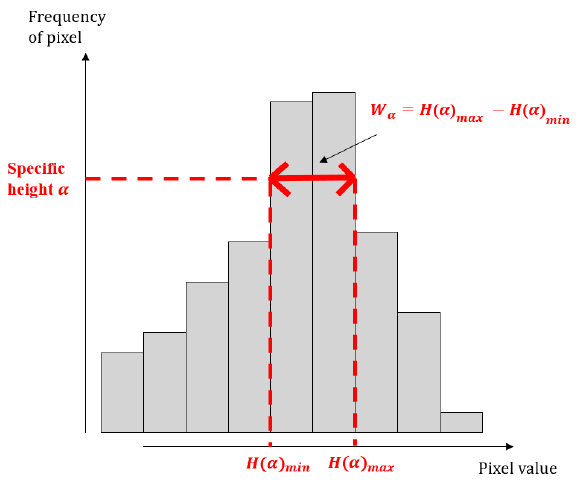
Figure 4. The H ( α ) 𝐻(𝛼) α in the image histogram. and H ( α ) at specific height α in the image histogram. Figure 4. The 𝐻(α) Figure 4. The 𝐻(α) (cid:3040)(cid:3036)(cid:3041) and 𝐻(𝛼) (cid:3040)(cid:3028)(cid:3051) at specific height α in the image histogram. min max (cid:3040)(cid:3036)(cid:3041) and (cid:3040)(cid:3028)(cid:3051) at specific height